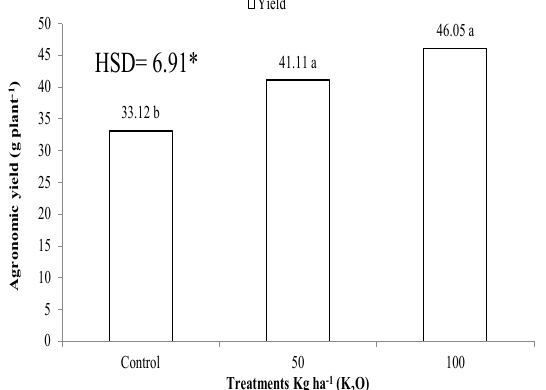
Figure 1. Sunflower agronomic yield ( Helianthus annuus L.), under three levels of potassium. Universidad Tecnológica de Tehuacán. Summer, 2017. HSD, honest significant difference.